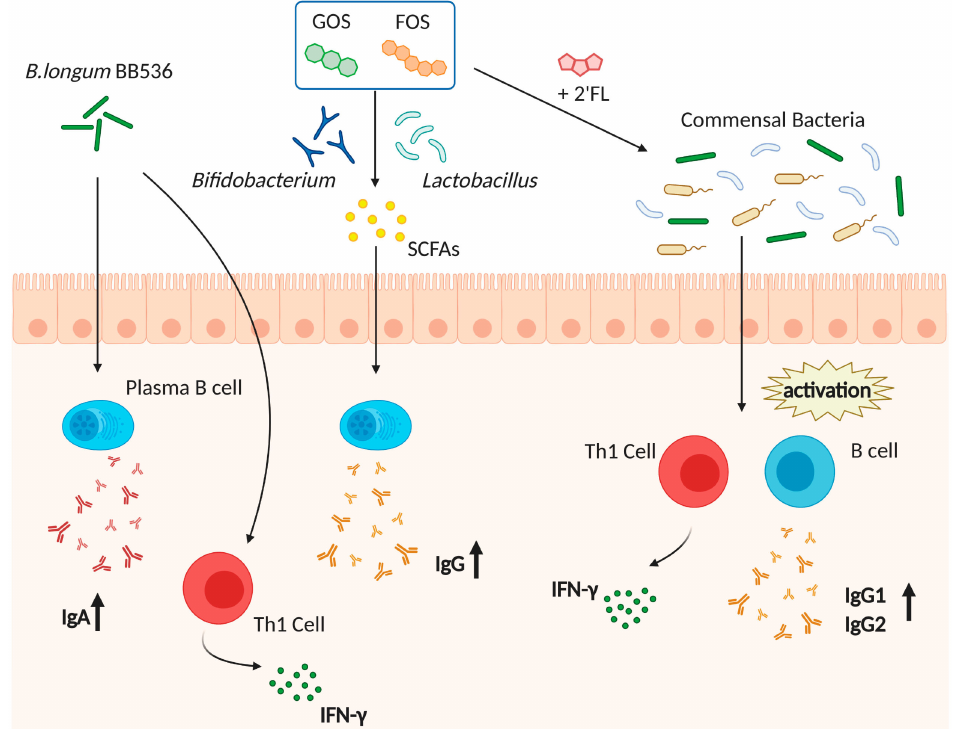
Figure 1. Prebiotics and probiotics interventions improve influenza virus vaccine efficacy. The use of prebiotics and probiotics improves vaccine efficacy, impacting host immune cells. As probiotics, Bifidobacterium longum BB536 might promote the secretion of IgA and IFN- γ . As prebiotics, galac- tooligosaccharide (GOS) and fructooligosaccharide (FOS), induce the increase in Bifidobacterium or Lactobacillus and the levels of short-chain fatty acids (SCFAs) in the gut, which in turn promote the in- crease in IgG levels. Additionally, treatment with long-chain GOS/short-chain FOS/2 (cid:48) -fucosyllactose (2 (cid:48) -FL) promotes the activation of influenza vaccine-specific Th1 and B cells, resulting in higher IgG1 and IgG2 levels via symbiotic